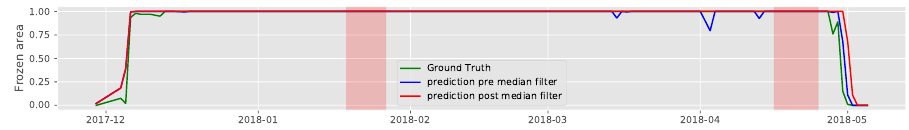
Figure 19. Cross-camera time series results (winter 17–18) of lake St. Moritz using Deep-U-Lab . Results for camera 1 (when trained on camera 0 data) is displayed. All dates are shown in chronological order on the x-axis and the respective results (percentage of frozen pixels) are plotted on the y-axis. Data lost due to technical failures are shown as red